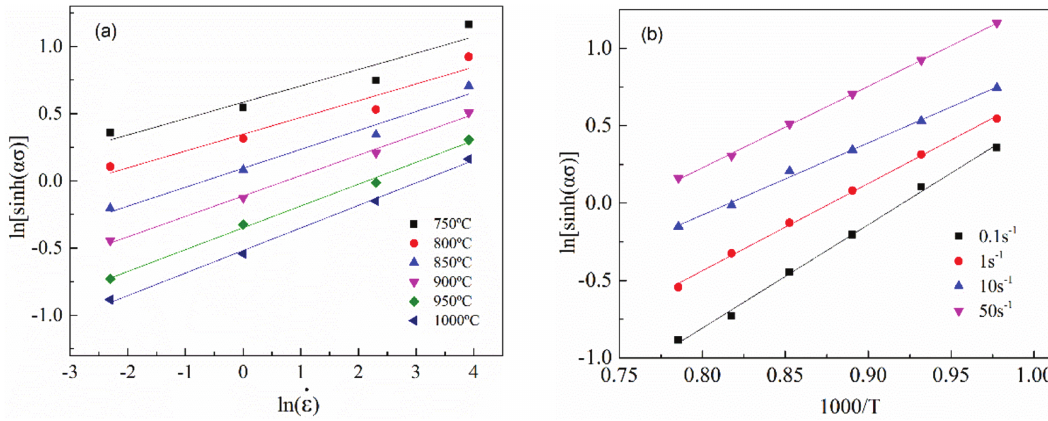
Figure 6: The linear relationships of (a) ln sinh ασ ð Þ½ (cid:2) and ln _ ε (b) ln sinh ασ ð Þ½ (cid:2) and 1000/T.